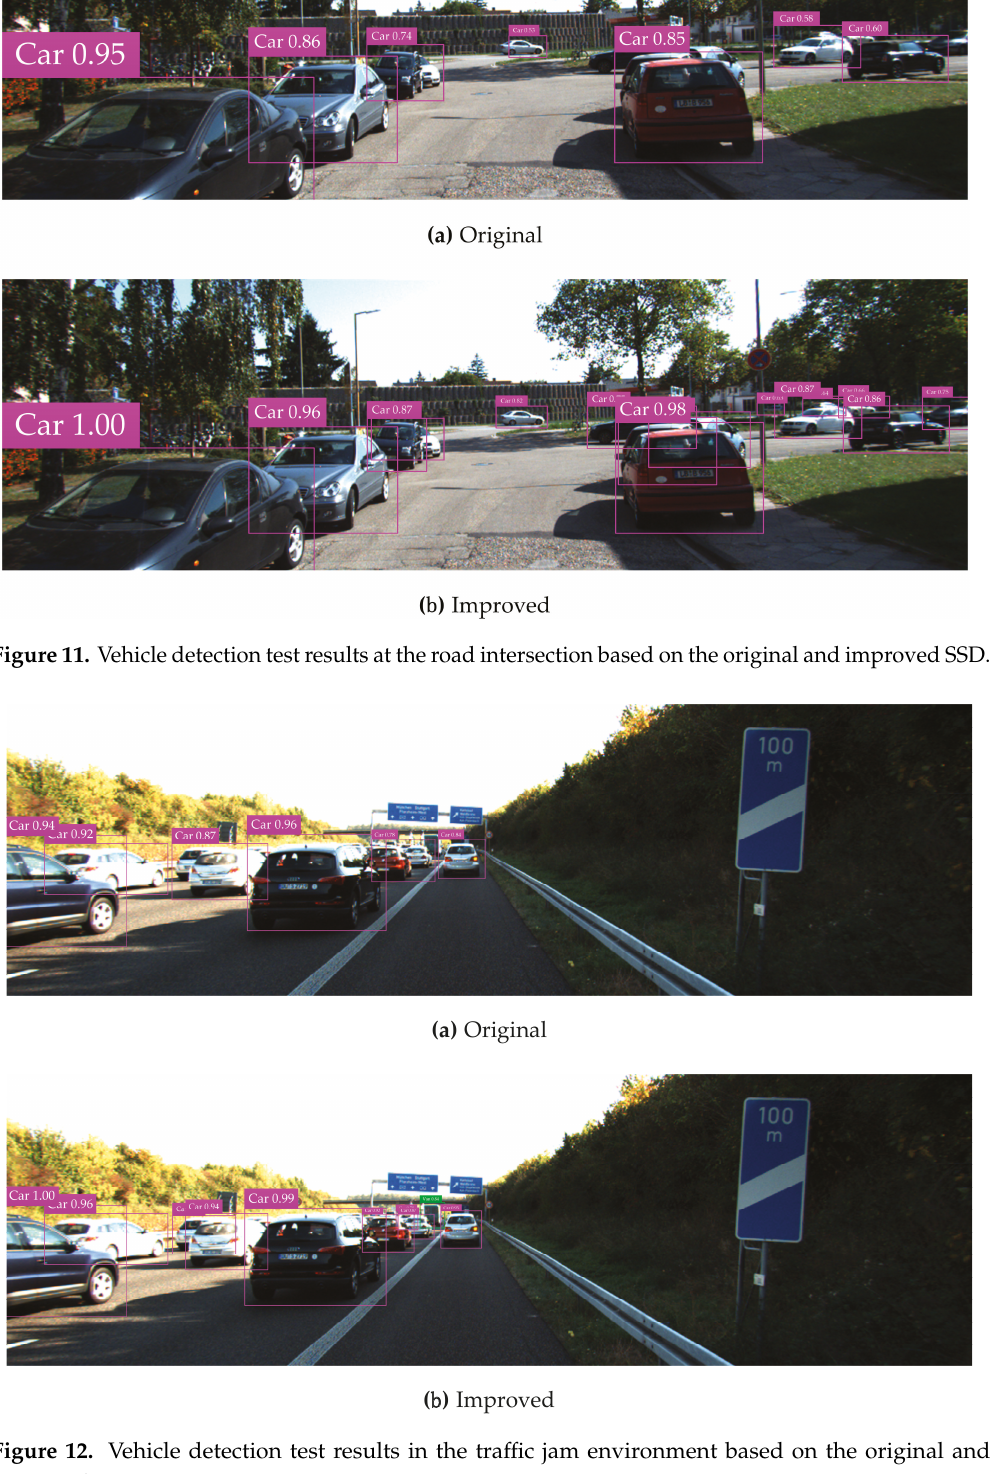
Figure 12. Vehicle detection test results in the tra ffi c jam environment based on the original and improved